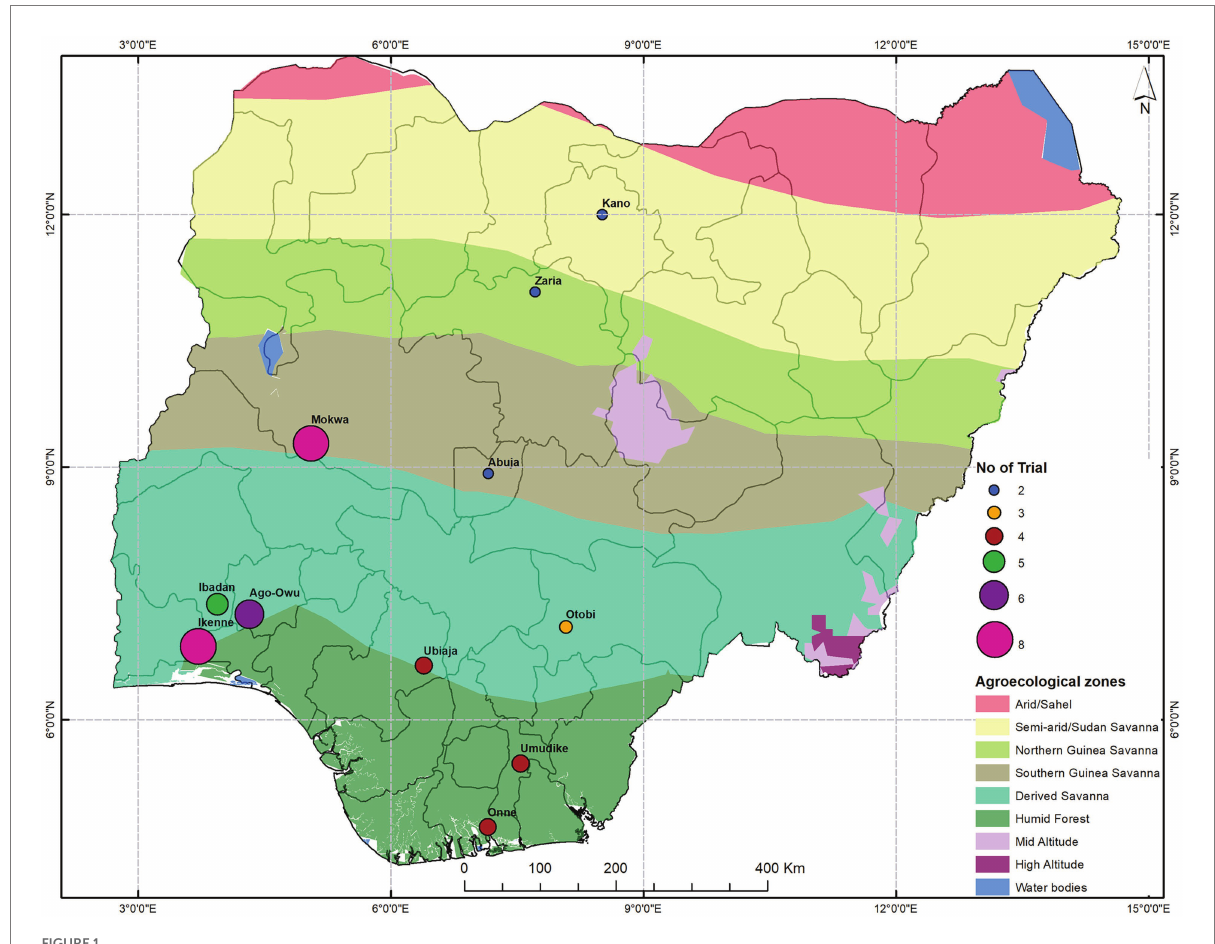
FIGURE 1 A map of Nigeria showing the trial geographical locations across agro-ecological